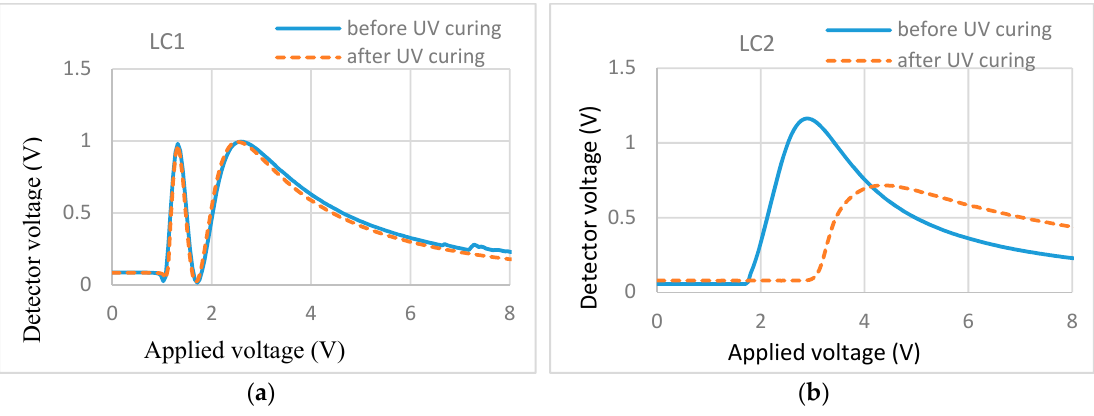
Figure 5. T/V curves of ( a ) 1.5% RM257 in E7 and ( b ) 1.5% RM257 in ZLI-4792.